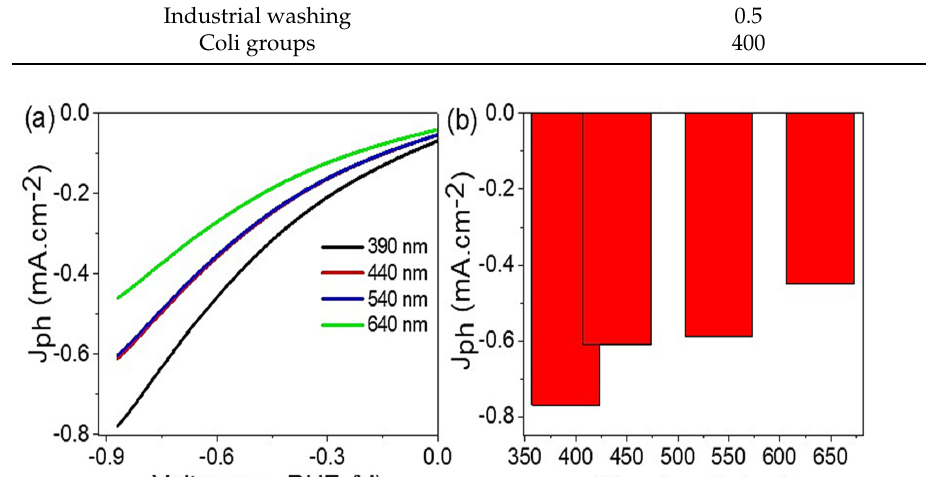
Table 1. The chemical composition of the sewage water used as an electrolyte for H 2 gas produc- tion.